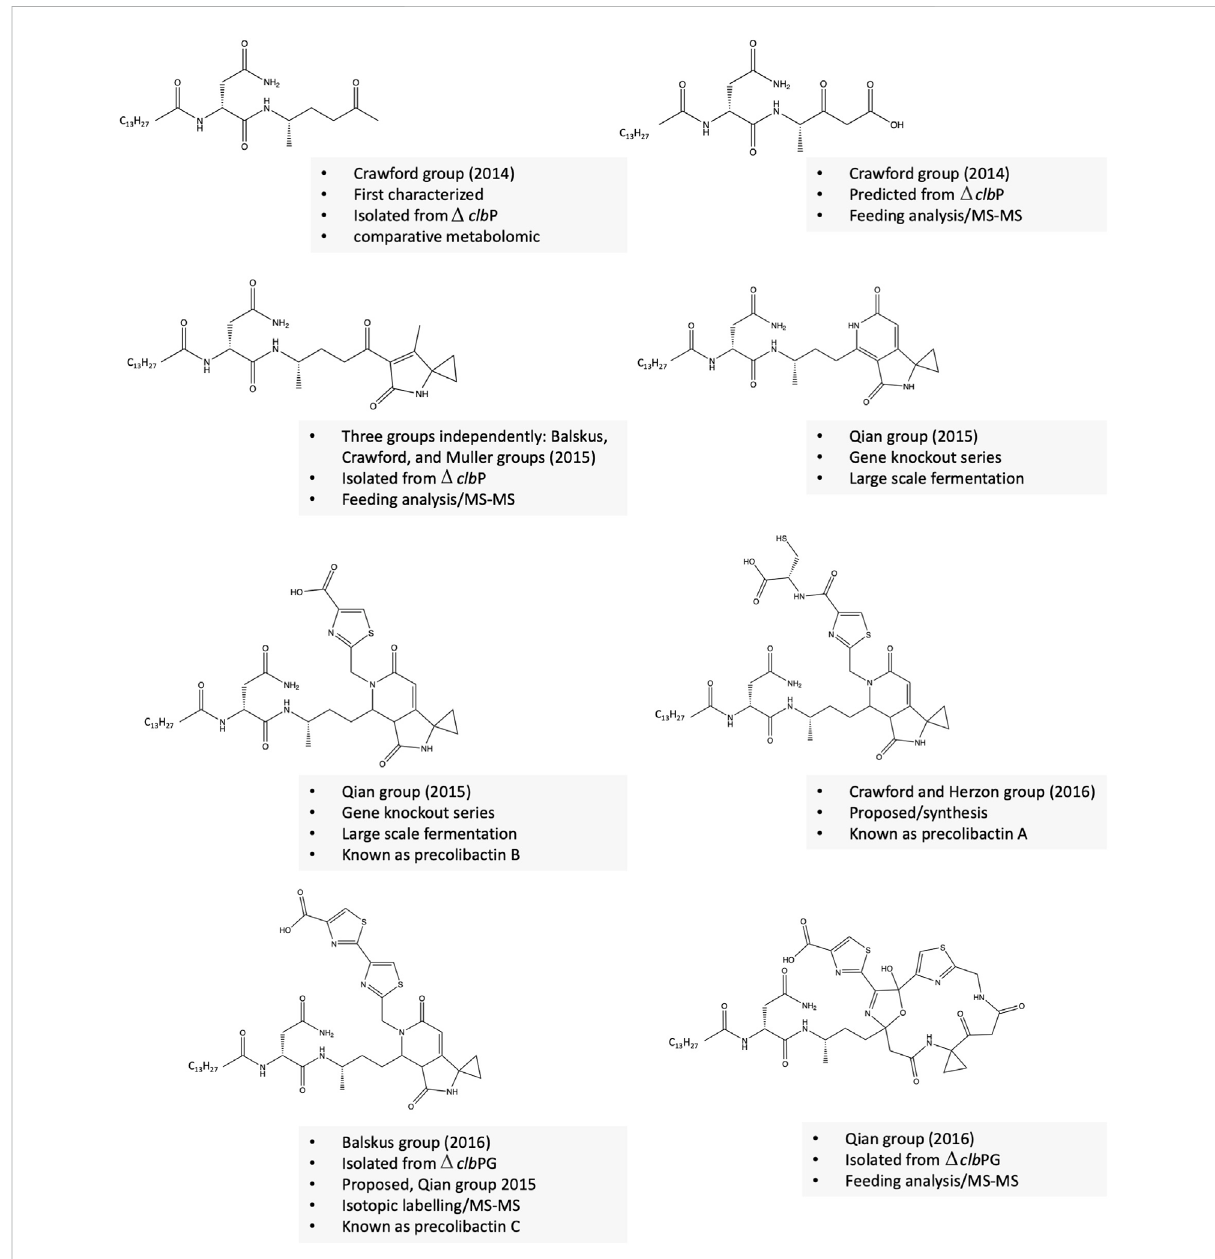
FIGURE 2 Selected examples of precolibactins with unique